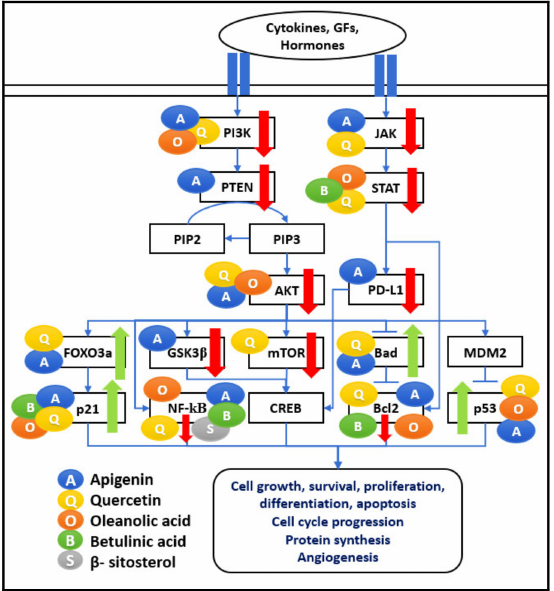
Figure 4. PI3K/AKT/mTOR and JAK/STAT network. The five bioactive compounds detailed in this review show a range of immunomodulatory activities. Various research articles have reported their scattered effects on significant pathways such as PI3K/AKT/mTOR, JAK-STAT pathways regulating cell proliferation, angiogenesis, protein synthesis, cell survival, and cell cycle progression. These bioactive compounds are shown as coloured circles and are indicated alongside their respective molecular targets (Blue: Apigenin, Yellow: Quercetin, Orange: Oleanolic acid, Green: Betulinic acid, Grey: β -Sitosterol). The bold red arrows indicate the downregulation of respective pathways, and bold green arrows indicate the upregulation of the particular pathway. The entities of bold square boxes represent different signaling molecules/complexes. The entities of dotted square boxes represent different receptors for signaling pathways. The entities of circle boxes represent the inducers/activators of the particular pathways. → represents direct activation and (cid:97) represents